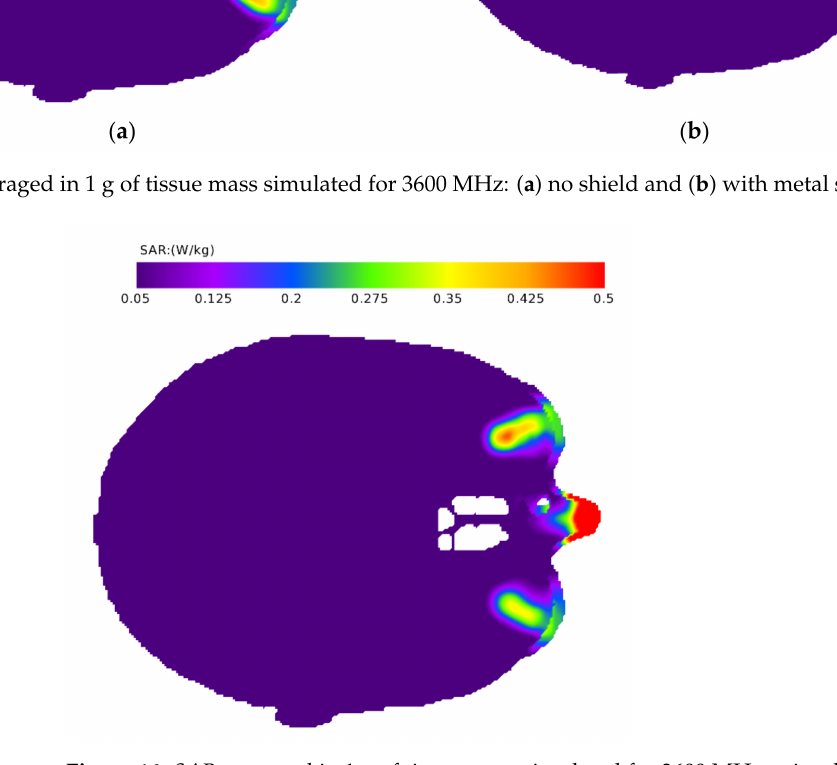
Figure 16. SAR averaged in 1 g of tissue mass simulated for 3600 MHz, wire